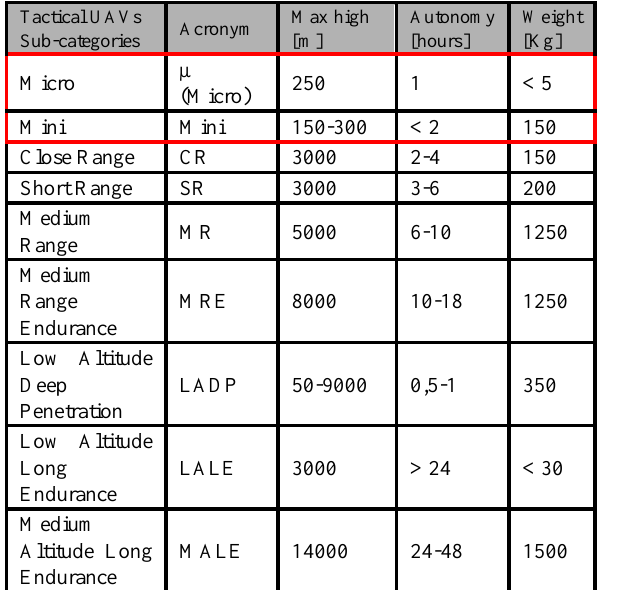
Figure 1. Schematic diagram of the system used based on Hexakopter by